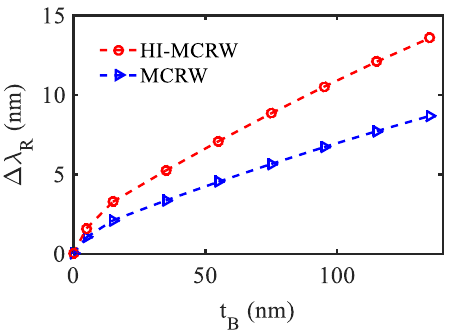
Figure 10. Shift in resonance wavelength for the HI-MCRW and MCRW corresponding to EV detection.